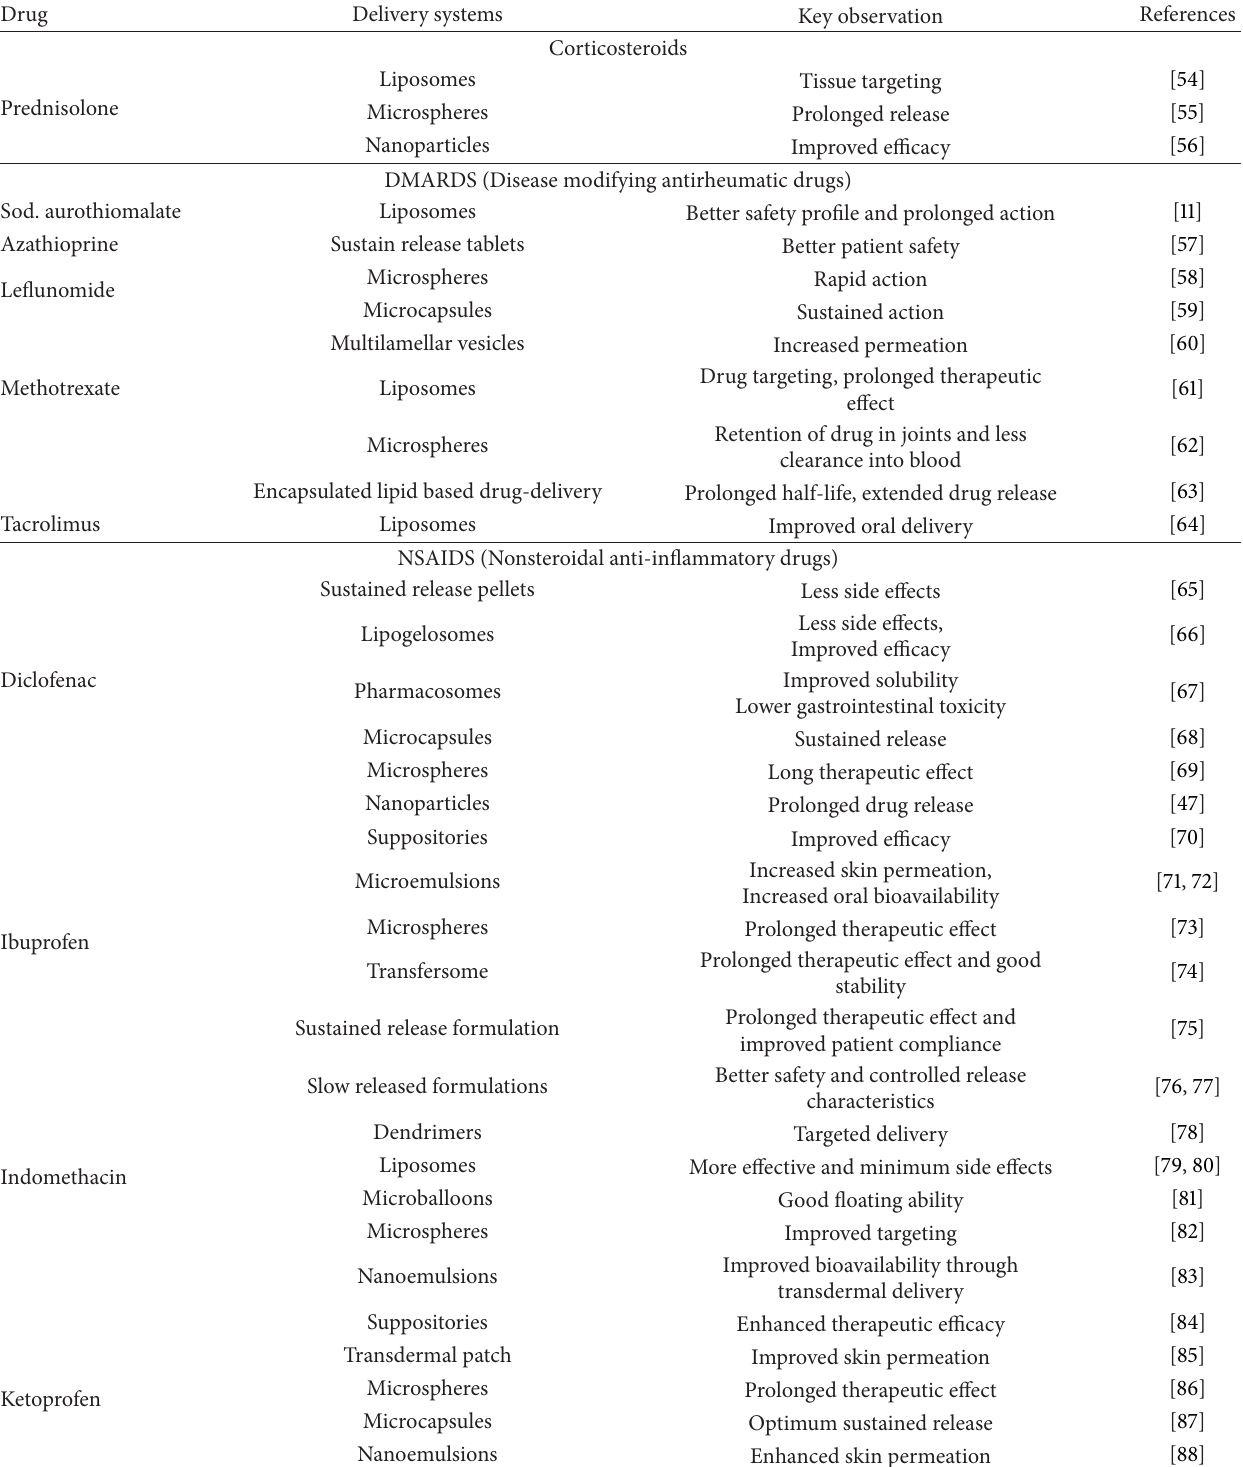
Table 2: Various drugs and their delivery approaches for the effective treatment of rheumatoid arthritis.